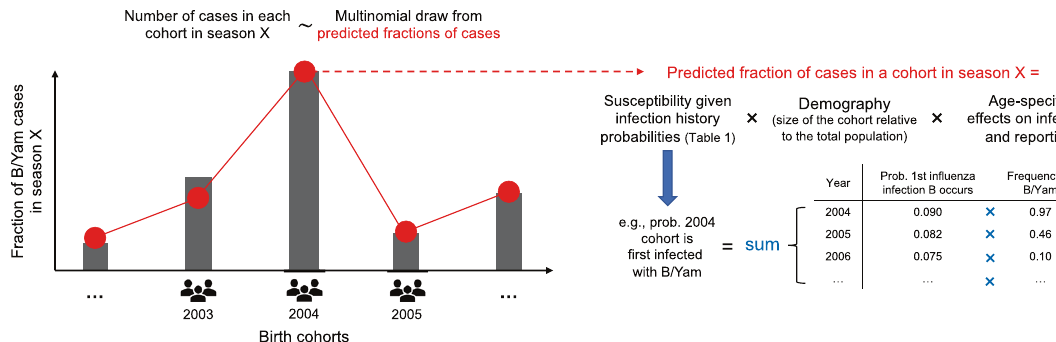
Fig. 2 Statistical model of in fl uenza B infections by birth year. Extending the model developed by Gostic et al. 10 , for each in fl uenza B season we predicted the fraction of cases observed in each cohort based on cohort-speci fi c infection histories and on additional factors. The probabilities of the different infection histories in Table 1 are derived in the “ Methods ” using a discrete-time probabilistic model of infection. As an example, the diagram shows how the probability that a person is fi rst infected with B/Yamagata depends on the frequency of B/Yamagata in the years after birth. Given a person ’ s fi rst in fl uenza B infection occurs in a particular year, we assumed that the probability this infection was caused by a particular lineage is equal to the frequency of the lineage in that year. We obtained the total probability of being fi rst infected with a particular lineage by summing across all possible years when the fi rst in fl uenza B infection might have occurred. The susceptibility of each cohort is then calculated as a weighted sum of the susceptibilities associated with each infection history. In addition to infection history, other factors that affect the fraction of cases observed in a birth cohort include the cohort ’ s size relative to the total population and the effect of age itself (rather than year of birth) on infection risk and on the probability that an infection receives medical attention and becomes a case. We fi tted the model by maximum likelihood assuming the distributions of cases by birth year in different seasons were independent multinomial